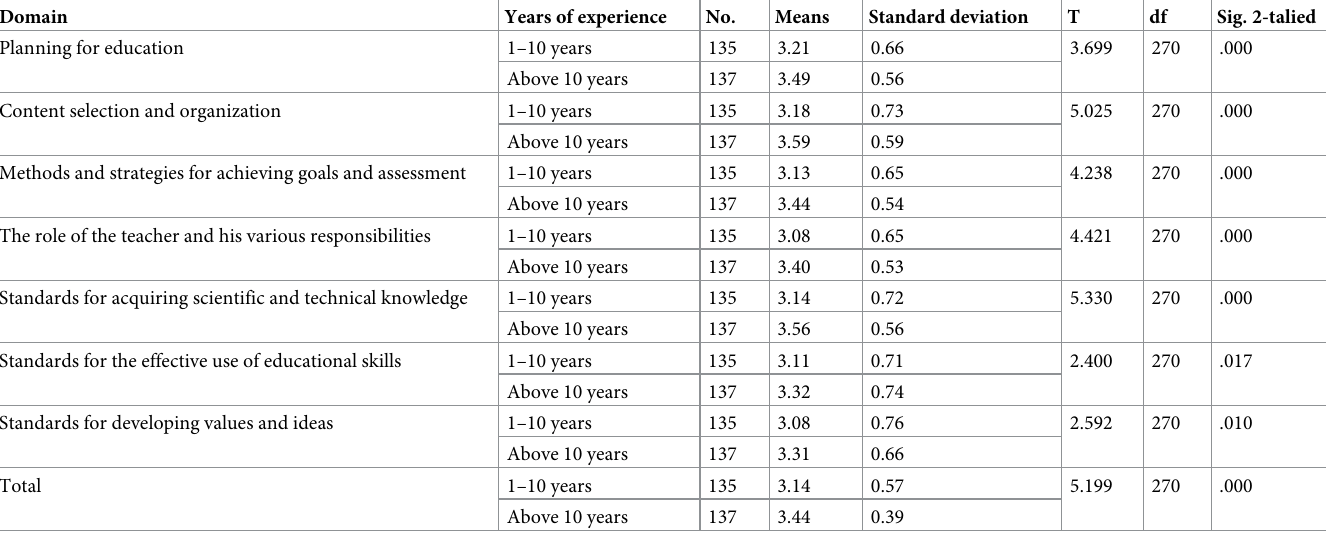
Table 7. T-test analysis for the quality assessment of the training programs for students with disabilities in light of modern trends attributed to years of experience.